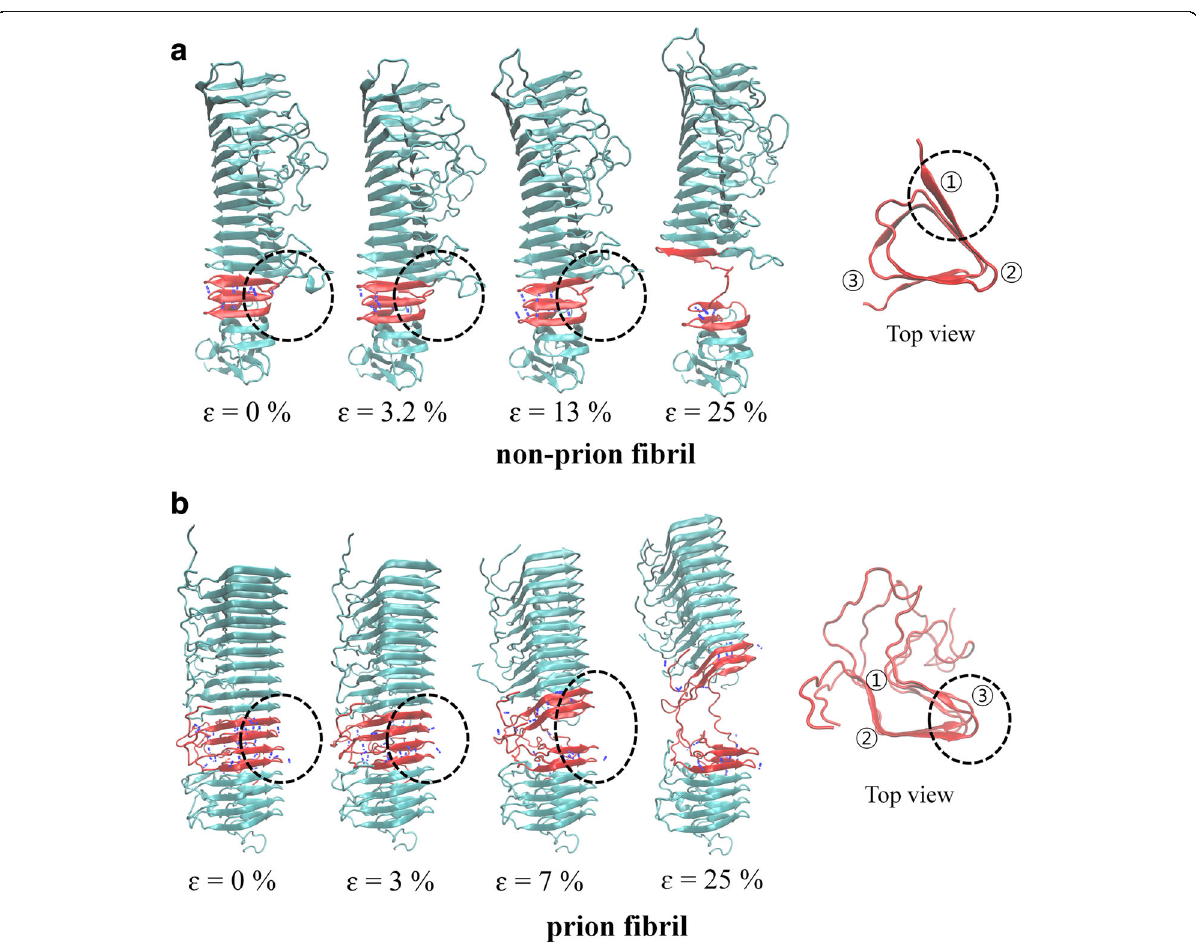
Fig. 4 Deformation and failure pathways of a non-prion fibril and b prion fibril as a function of strain. The black dashed circles indicate the region at which the fracture of the fibril begins